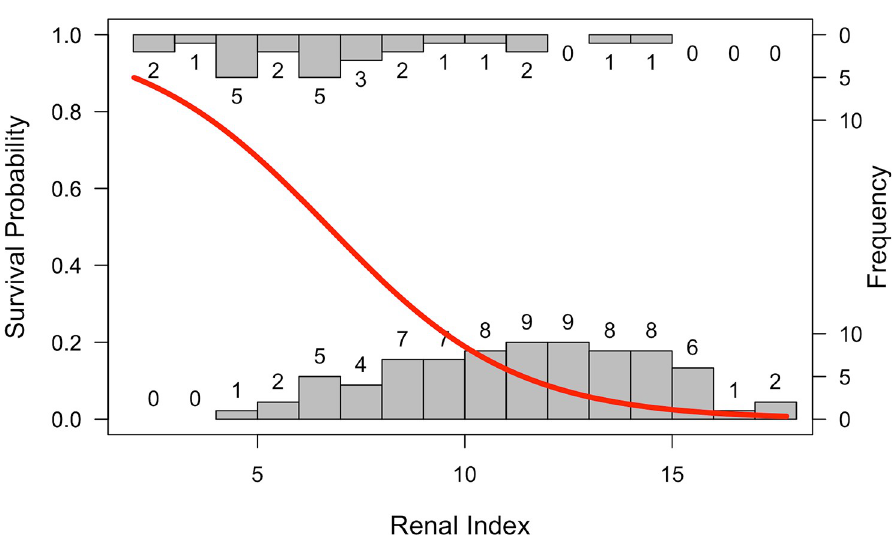
Fig 6. Survival probability predicted from renal index score. The probability of survival as a function of renal index score plotted over histograms of the number of animals surviving (top histogram) or not surviving (bottom histogram) by renal index value. Analyses were run using data from samples collected within 72 hours of admission to a rehabilitation center from animals stranding and diagnosed with leptospirosis.